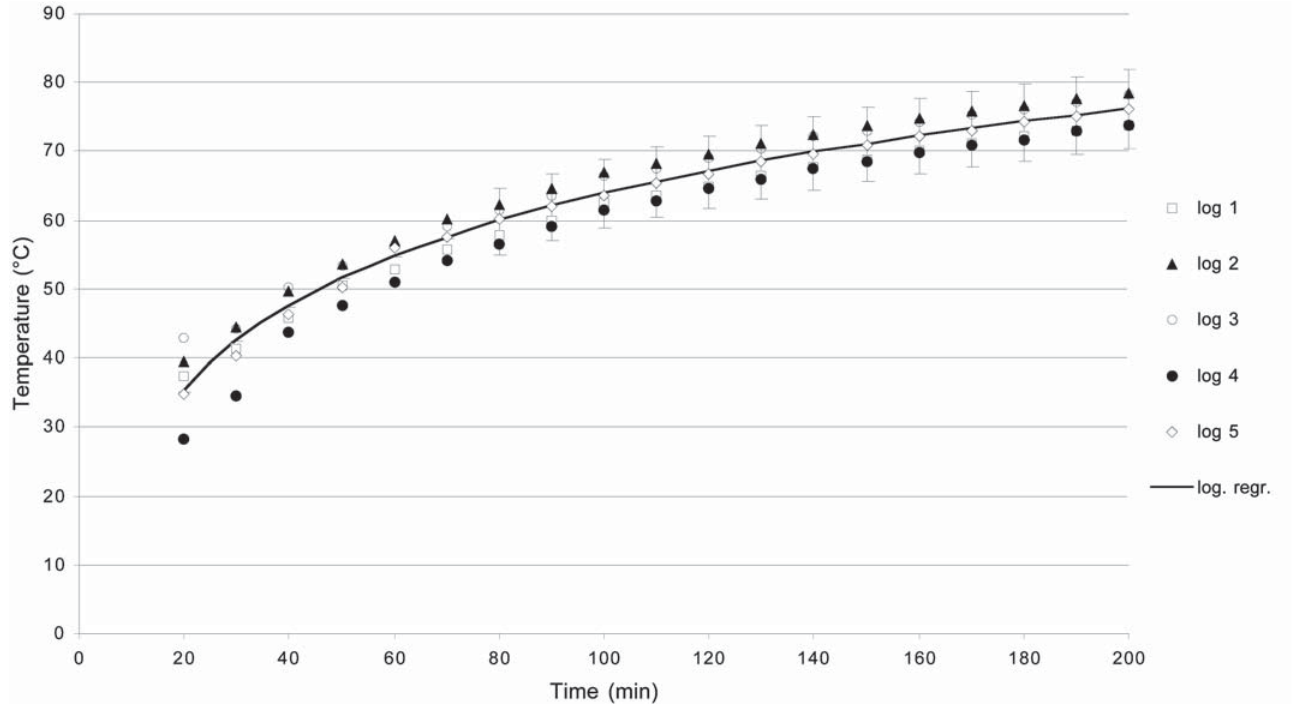
Fig. 2. Temperature variation with time at 100 cm from the head of a log and at 30 mm depth. Confidence intervals refer to the equation y=-18,2253 + 17,80246 ln x (R 2